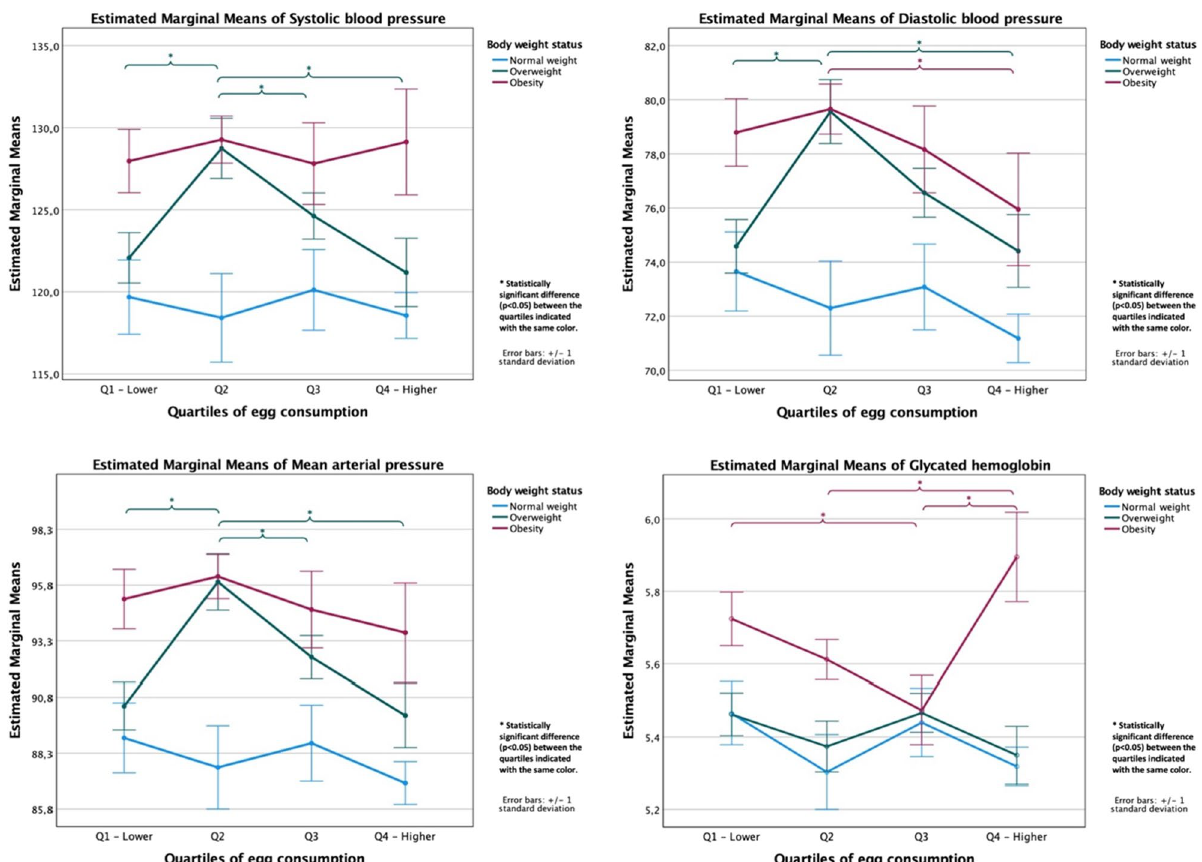
Figure 1. Estimated marginal means (± 1 standard deviation) of blood pressure and glycated hemoglobin according to body weight status obtained with ANCOVA models adjusted for age (continuous, years), sex (male, female), BMI (continuous, Kg/m 2 ), education level (primary or secondary studies, university studies), smoking status (nonsmoker or former smoker, current smoker), alcohol intake (nondrinker, current alcohol drinker), total energy intake (continuous, kcal/day), adherence to the Mediterranean Diet (continuous, MEDAS score) and moderate-to-vigorous physical activity (continuous,